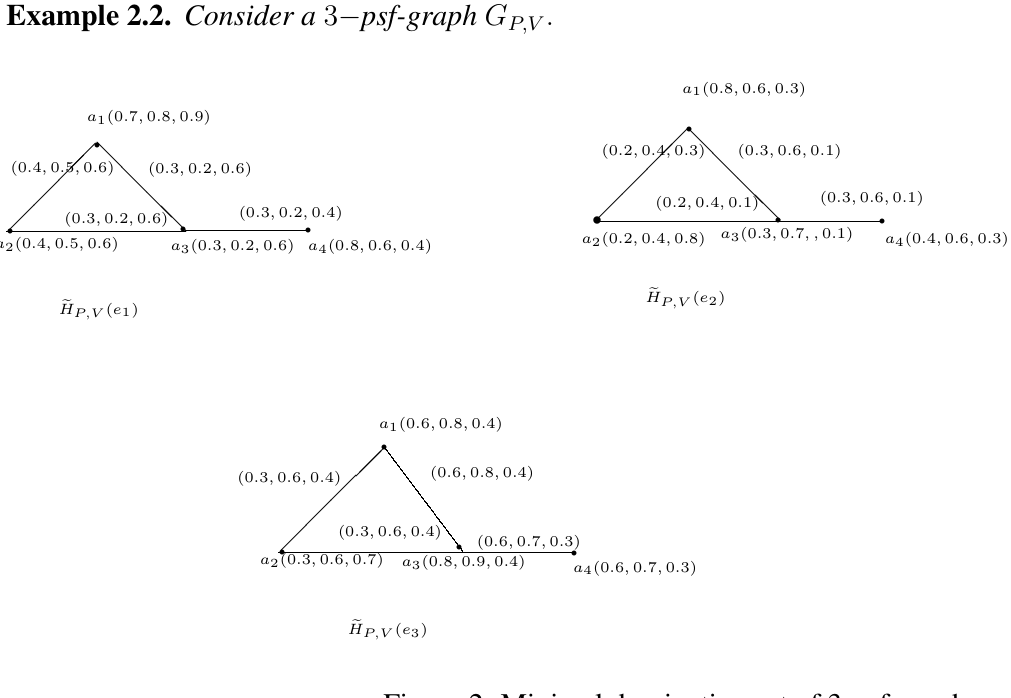
Figure.2. Minimal dominating set of